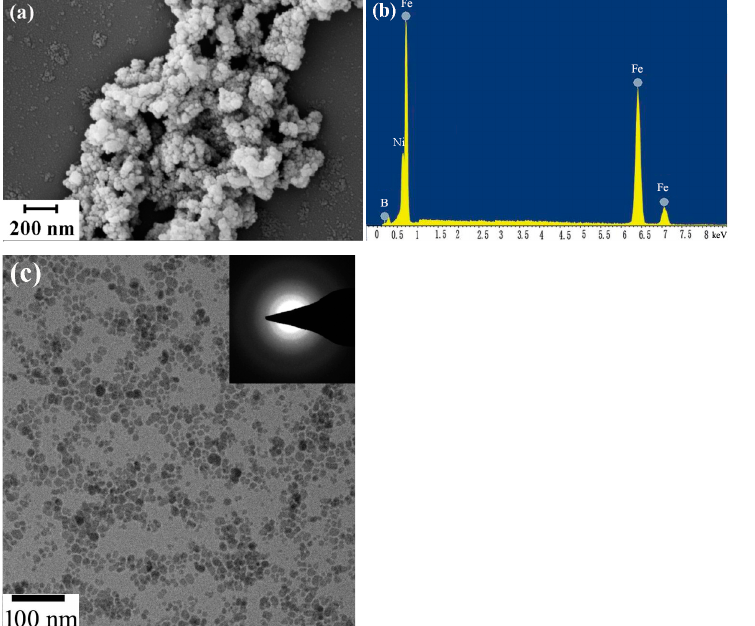
Figure 3. SEM image of amorphous Fe-Ni-B particles ( a ) , EDX spectra of Fe-Ni-B amorphous magnetic particles ( b ), and TEM image of amorphous Fe-Ni-B particles ( c ).